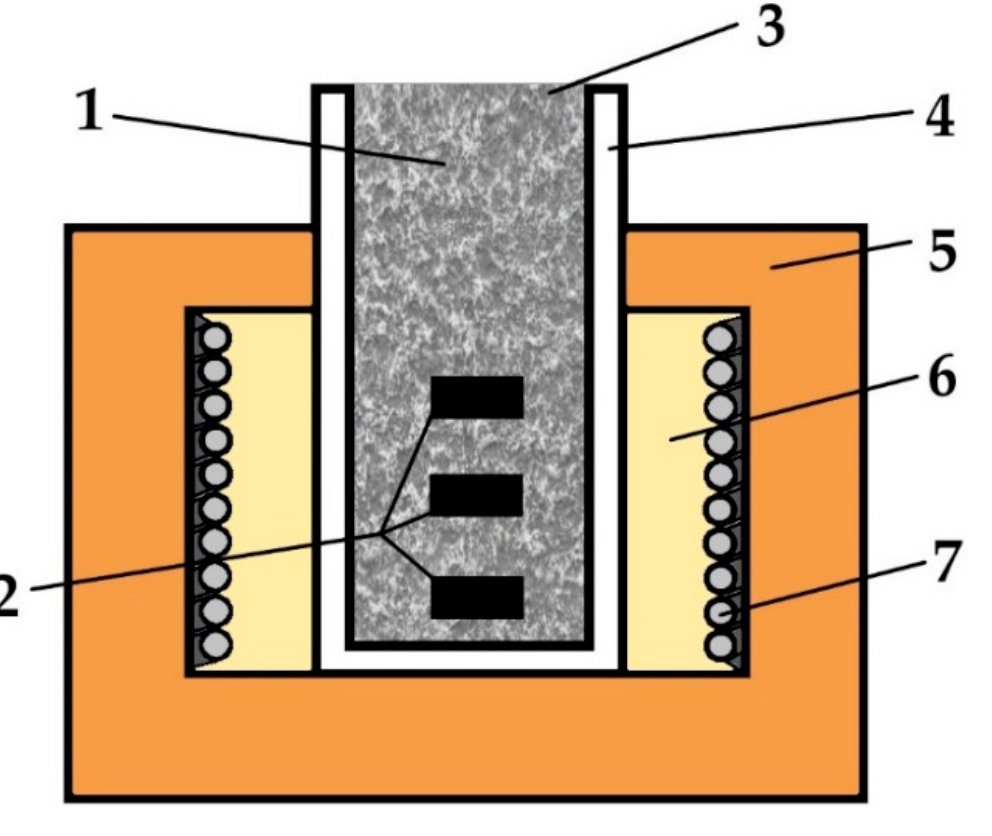
Figure 1. Scheme of device used for powder-pack boriding with an open retort: 1—powder mix- ture, 2—treated samples, 3—the open upper part of the retort, 4—tube-shaped retort with a closed bottom, 5—electric resistance furnace, 6—furnace chamber, 7—heating elements.